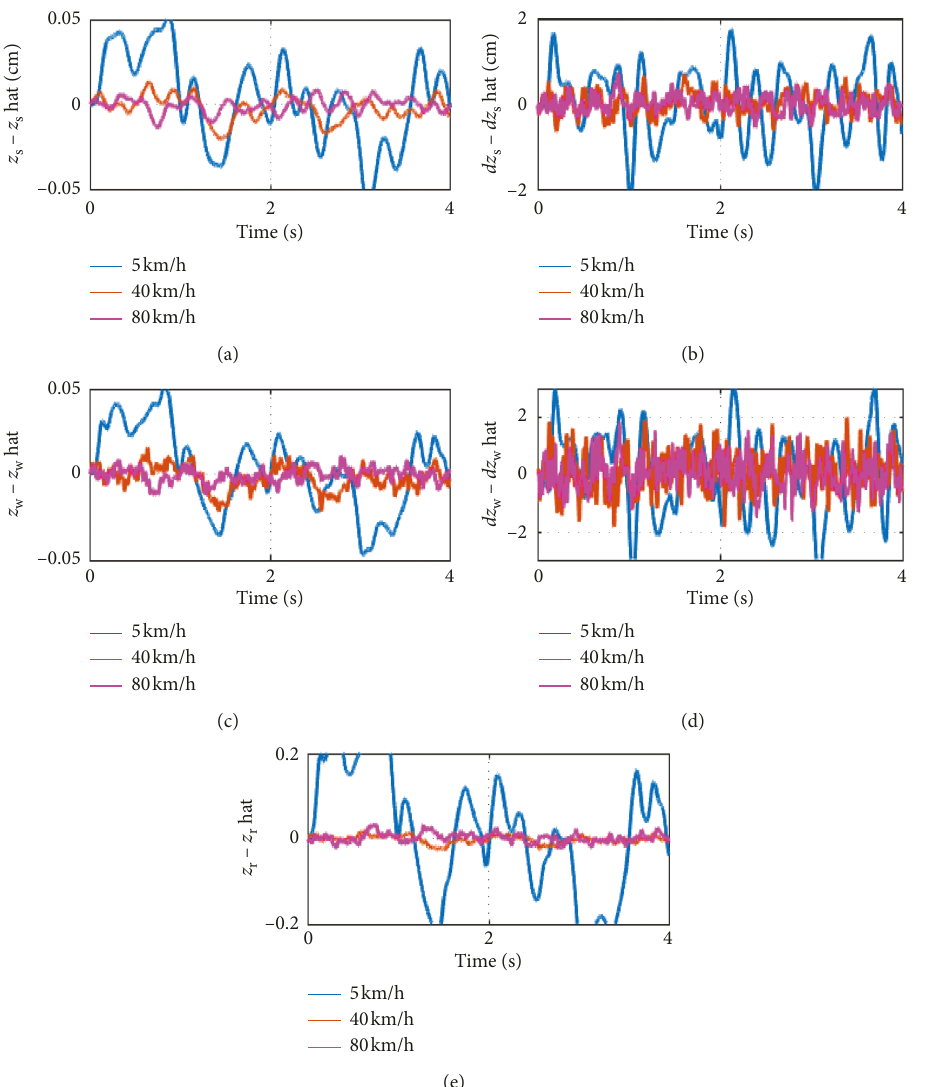
Figure 17: The state estimation errors by the velocities of the car. (a) z